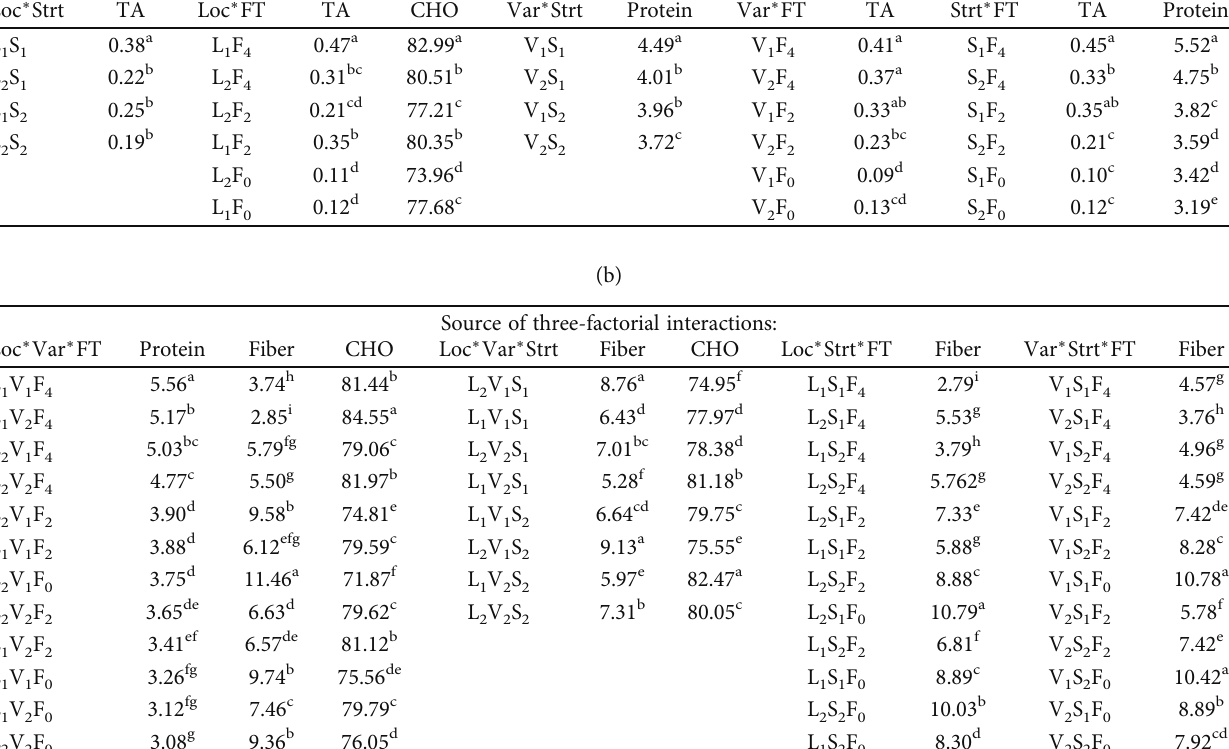
(a) Source of two-factorial